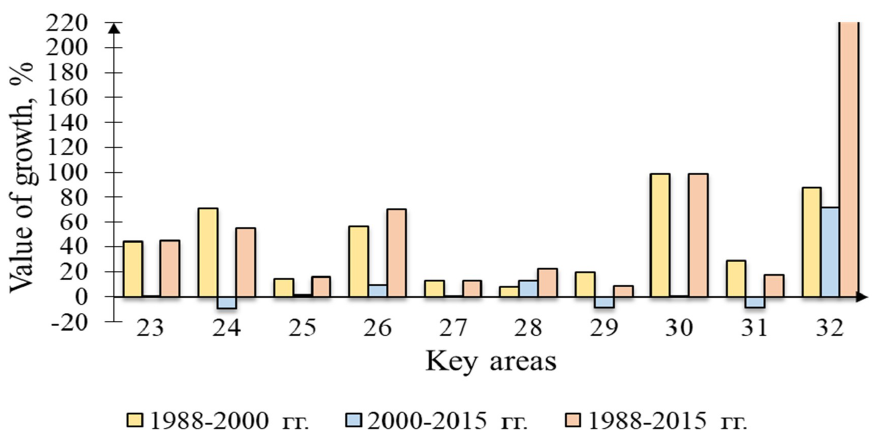
Figure 9. The dynamics of the horizontal dissection of the ephemeral gully network (Medveditsa river basin) for the periods 1988–2000, 2000–2015 and from 1988 to 2015.